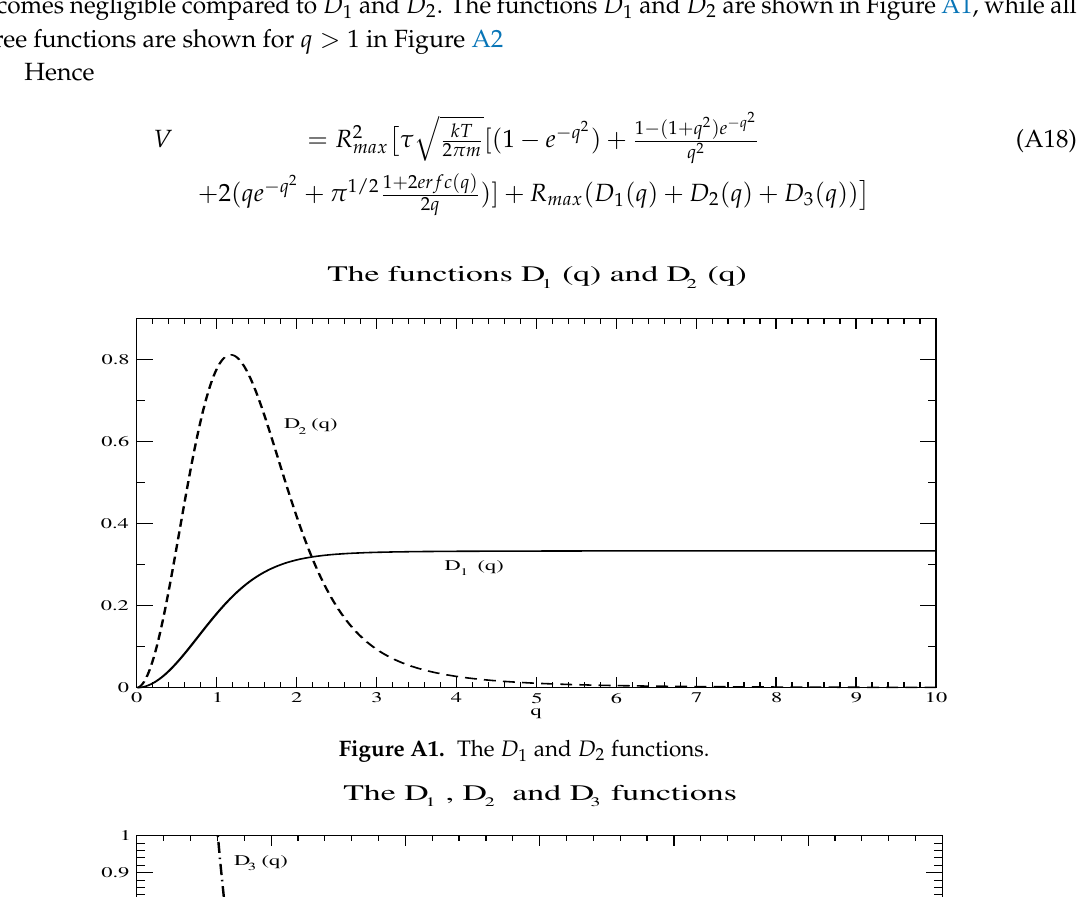
Figure A1. The D 1 and D 2 functions.